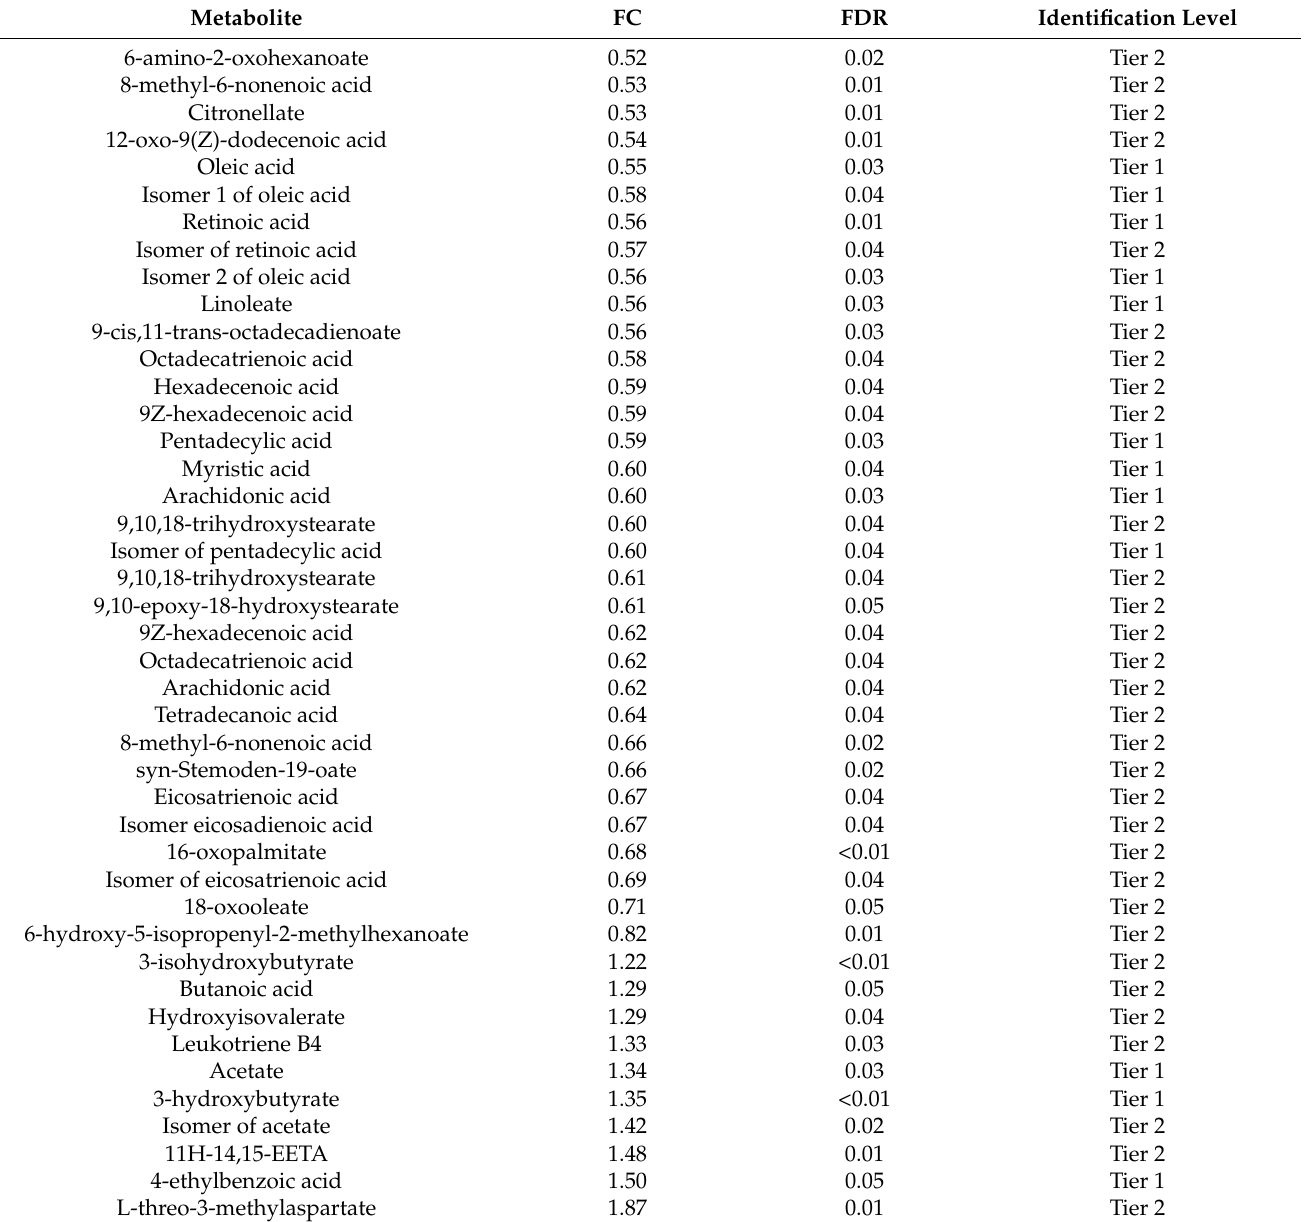
Table 1. Differentially abundant plasma carboxylic-acid-containing metabolites between LF and HF steers.